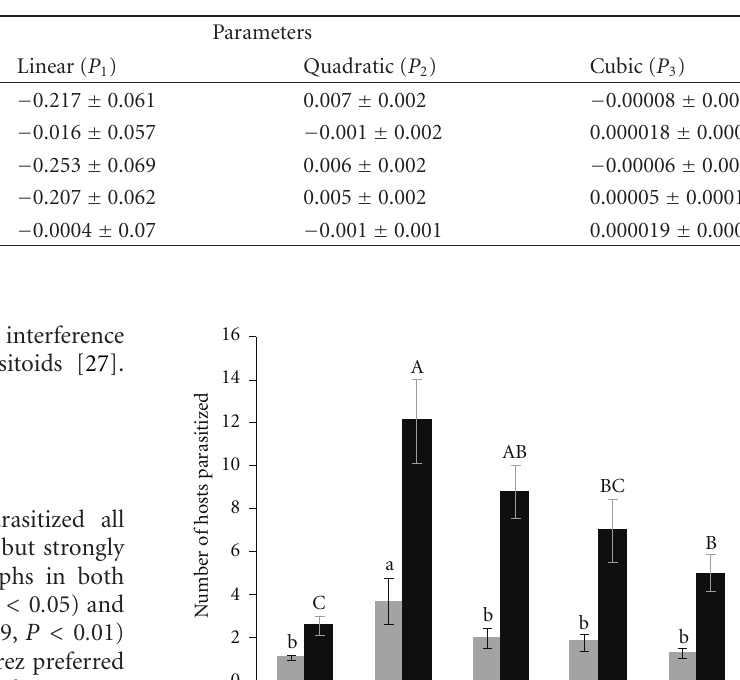
Table 1: Maximum likelihood estimates from logistic regressions of proportion of di ff erent densities of Sitobion avenae by Praon volucre at various constant temperatures.